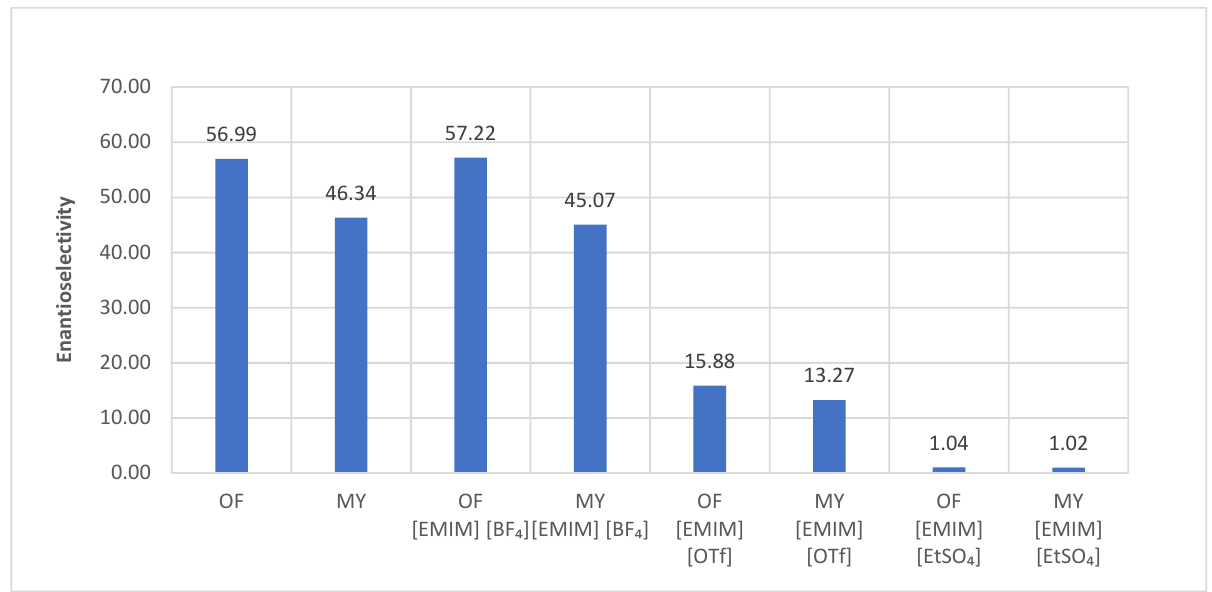
Figure 4. Overview of obtained results of performed enantioselective biotransformation of ( R , S )- atenolol after 120 h of incubation including enantioselectivity ( E ).